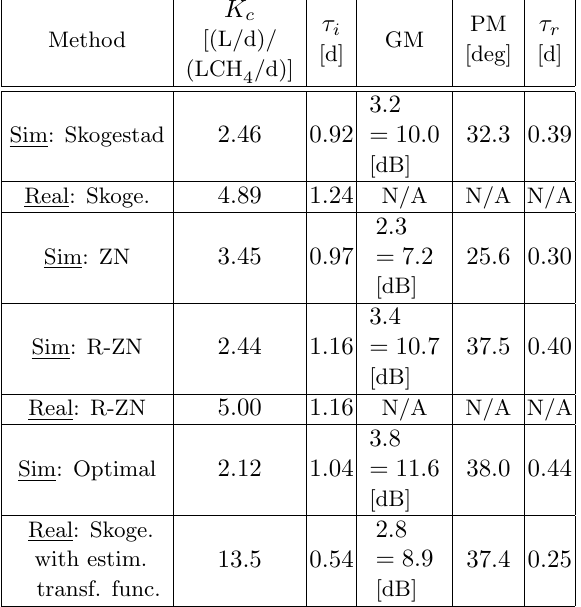
Table 2: Results with various PI tuning methods for simulated and for real